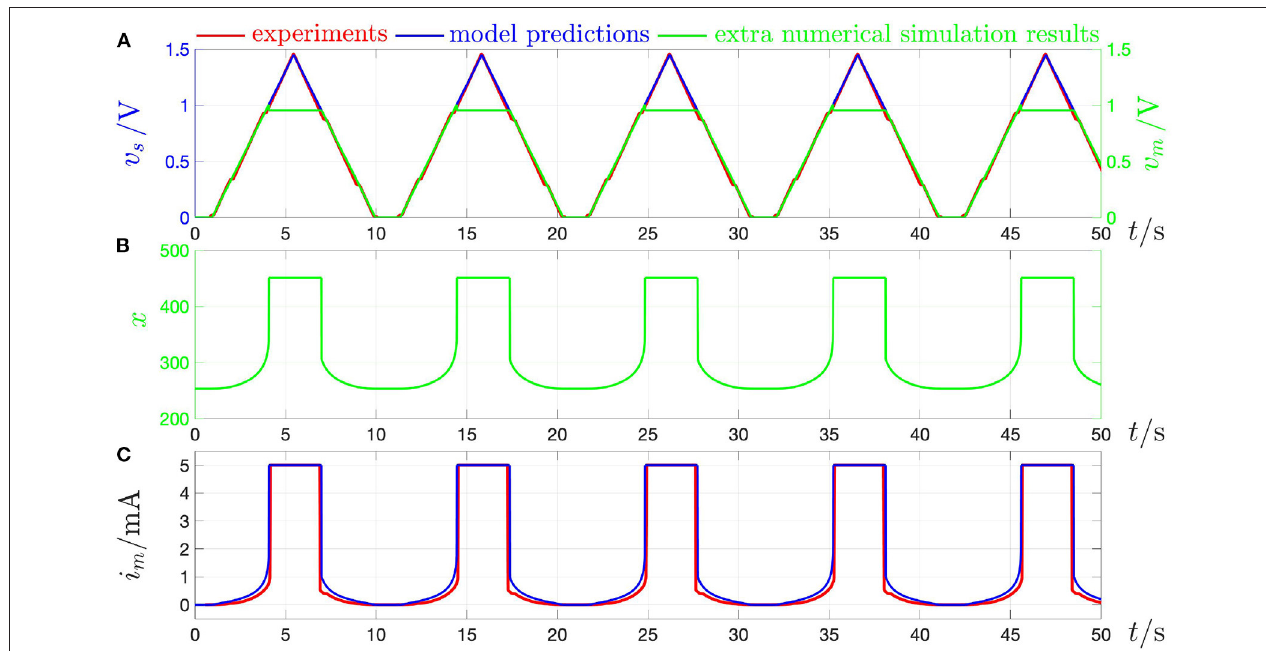
FIGURE 17 | Current compliance-constrained response of the NbO memristor to a quasi-DC voltage stimulus. (A) Strictly positive triangular voltage waveform v s of v s amplitude 1.45V and period T 9s falling directly across the device only when the latter is out of the compliance regime, and time waveform of the memristor ˆ = = voltage, which, when the current through the micro-structure attains the compliance level, descends abruptly to a fixed value, keeping unchanged thereafter till the time instant, at which the triangular stimulus descends below it. (B) Memory state response to the current-constrained quasi-DC voltage excitation test. (C) Current flowing through the device under the compliance-constrained quasi-static test. The red and blue waveforms in (A,C) were respectively extracted from experimental measurements performed at a chamber ambient temperature T amb of 20 ◦ C and from a numerical simulation of the model, consisting of the DAE set (3) and (4), with − state evolution and memductance functions, respectively, expressed by Equations (5) and (6), under nominal conditions, and of the DAE set (7) and (8), with state I c evolution and memristance functions, respectively, expressed by Equations (9) and (10), with i m 5mA, in compliance mode, for an initial condition x 0 , x (0s) = = equal to 253.15. The green waveforms in (A,B) report further results from the model simulation. Plotting the memristor current i m from (C) against the source voltage v s from (A) , i.e., against the voltage, which would fall across the micro-device in case it would never operate in compliance mode, results in the quasi-static current-voltage locus shown in Figure 19 through a blue dotted (magenta dashed) curve, as extracted via measurements (through a model numerical simulation). Six numbered arrows, referring to the magenta dashed curve, show the evolution of the trajectory point ( v s , i m ) over time in one input cycle. No point exists along the vertical line numbered 2 (5), when the micro-structure is abruptly transitioning into (out of) the compliance regime, when the locus visits data paths 3, and 4, i.e., the vertical lines are only drawn for visualizing better the sequence of events preceding and following the current-limited phase (see also Figure 20B on a compliance-free quasi-DC voltage excitation test with R s 0 (cid:127) ). With respect to the numerical simulation result, in case i m from (C) were plotted against v m from (A) in Figure 19 , the = resulting locus would differ from the i m – v s characteristic only over the compliance phase, when the only trajectory point from the arrowed path 3 4 of the magenta → dashed curve, which one would observe in this case after Q ( quasi − DC ) m , A and before Q ( quasi − DC ) m , C would be Q ( quasi − DC ) m , B , which coincides with the only possible device I c , as may be inferred via the load line analysis ( Q ( quasi − DC ) m , B represents the unique intersection point between the device operating point under current control with i m = I c associated to the compliance phase, when the quasi-DC voltage source across the DC I m – V m locus, shown in black in Figure 19 , and the horizontal load line I m = I c threshold switch acts as a DC current source of value I s =